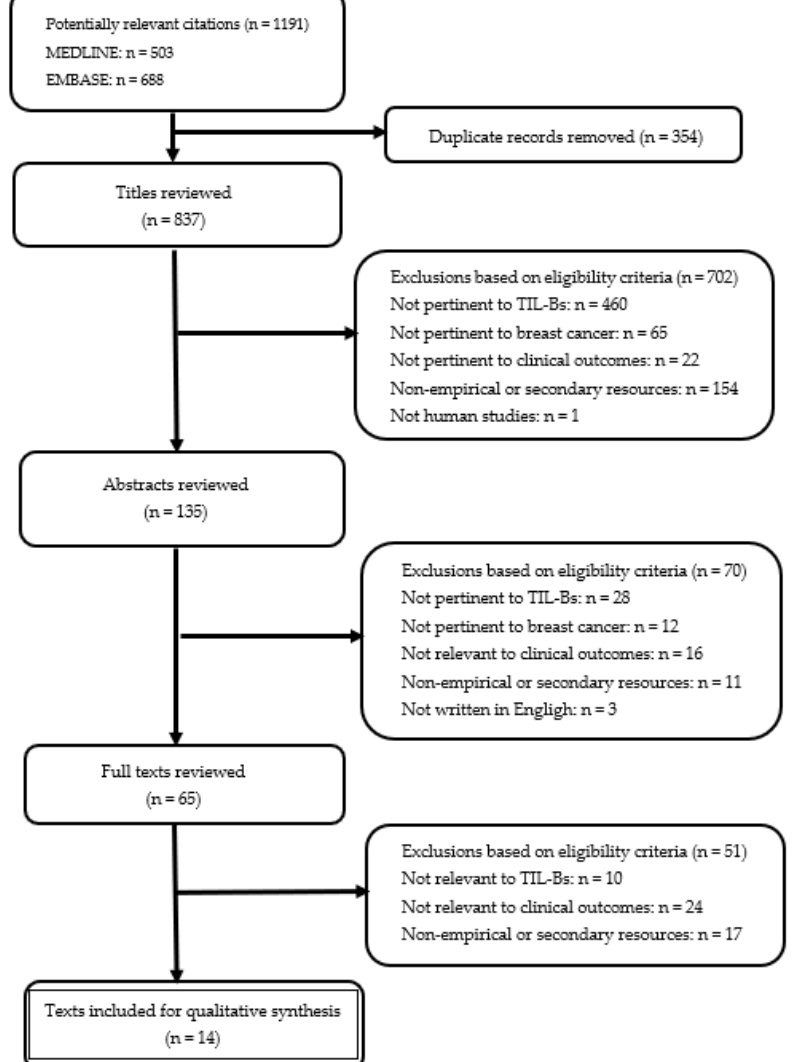
Figure 2. Flowchart describing the literature inclusion